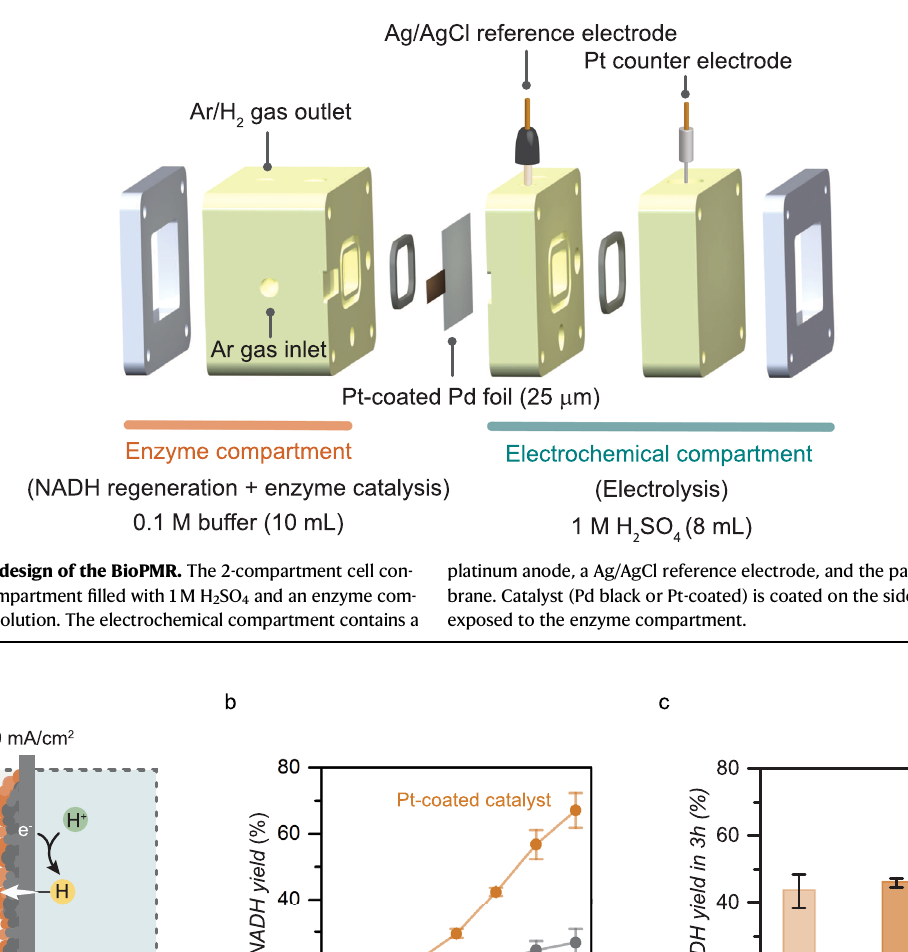
Fig. 3 | NADH generation performance in the ePMR. a Cell setup and idealized process for NADH generation. b Reaction pro fi le for 1,4-NADH generation with Pd blackcatalystand Pt-coated catalyst(Pt/Pdblack)intrisbufferatpH9. c 1,4-NADH yield in 3h with Pt-coatedcatalyst asa function of buffer pH (phosphate bufferfor